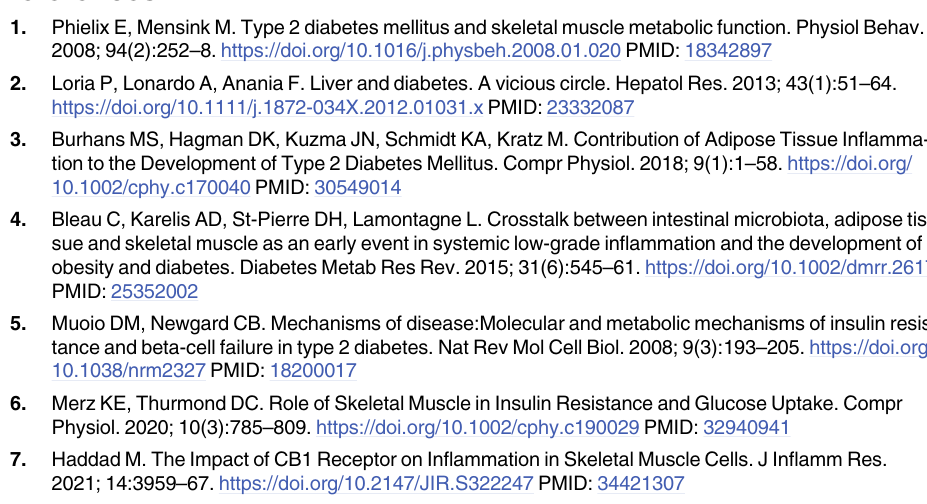
S1 Fig. Expression correlation between lncRNAs and their corresponding antisense pro- tein-coding genes. S1 Table. The expression level of lncRNAs in the skeletal muscle dataset used in this study. S2 Table. The expression level of lncRNAs in the kidney dataset used in this